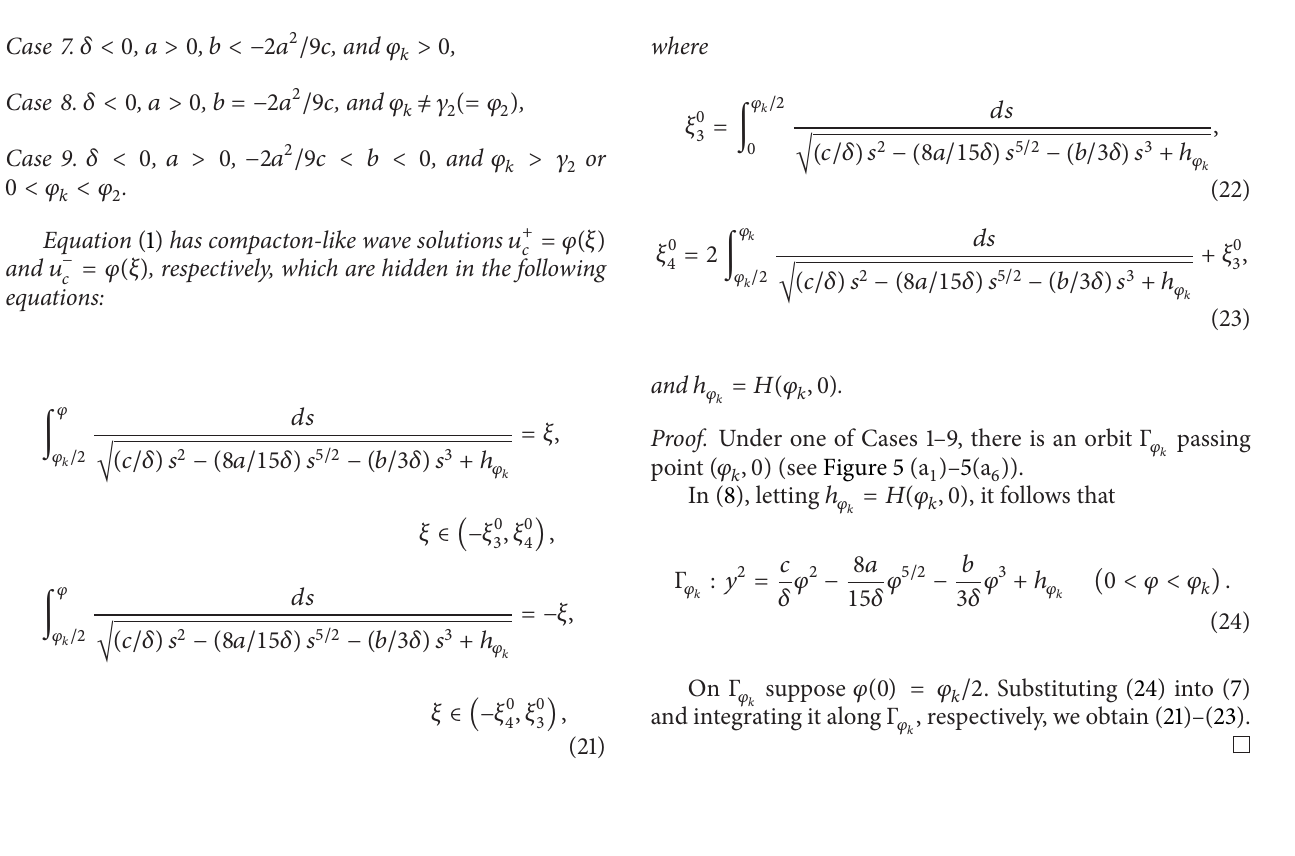
Figure 11: (The kink wave is bifurcated from the valley-shape solitary wave). The varying process for the graph of 𝑢 𝑓 when 𝑐 > 0 , 𝛿 > 0 , 𝑎 > 0 , and 𝑏 → −16𝑎 2 /75𝑐 − 0 , where 𝑐 = 1 , 𝛿 = 1 , 𝑎 = 1/2 , and (a) 𝑏 = −16𝑎 2 /75𝑐 − 10 −3 . (b) 𝑏 = −16𝑎 2 /75𝑐 − 10 −7 . (c) 𝑏 = −16𝑎 2 /75𝑐 − 10 −8 . (d) 𝑏 = −16𝑎 2 /75𝑐 − 10 −10